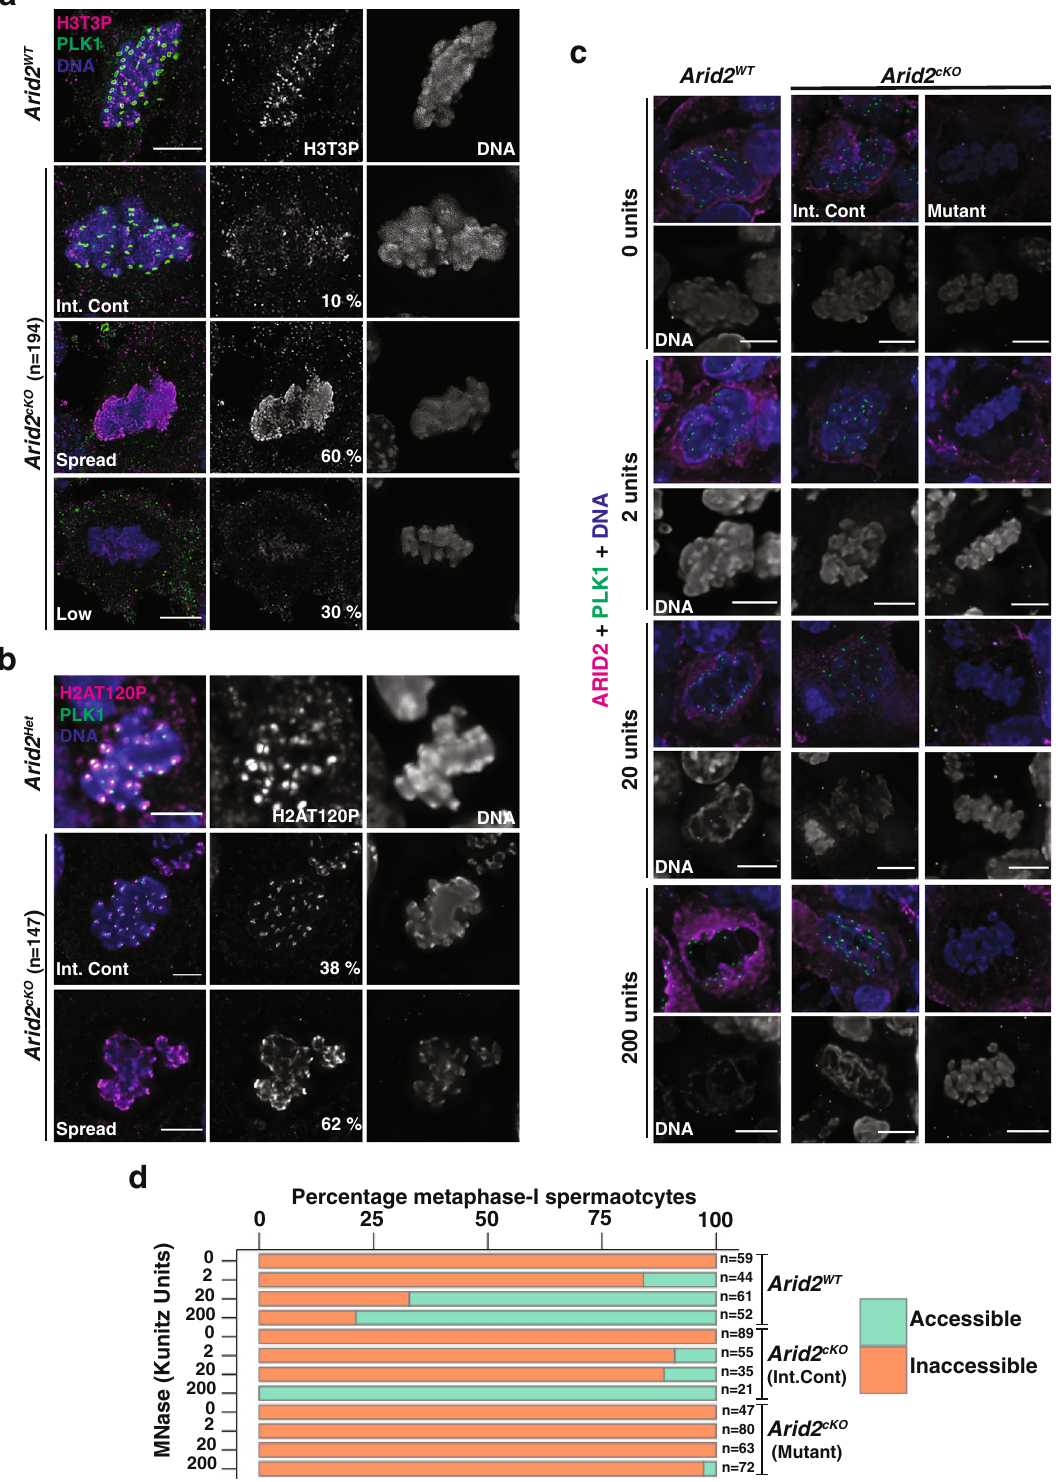
Fig. 3 ARID2 regulates chromatin organization in metaphase-I spermatocytes. a , b Control and Arid2 cKO metaphase-I spermatocyte squashes immunolabelled for PLK1 (green) and a H3T3P (magenta) and b H2AT120P (magenta). c , d Control and Arid2 cKO metaphase-I spermatocytes from cryosections treated with MNase (0 – 200 Kunitz units) c immunolabelled for PLK1 (green) and ARID2 (magenta), and d scored for chromatin accessibility indicated by the proportion of cells (horizontal axis) susceptible (accessible) or resistant (inaccessible) to MNase digestion at indicated MNase concentrations (vertical axis). The number of spermatocytes scored ( n ) are indicated. a – c DNA stained with DAPI. Scale bar: 5 μ m, magni fi cation: 100.8x. Int.Control: Internal